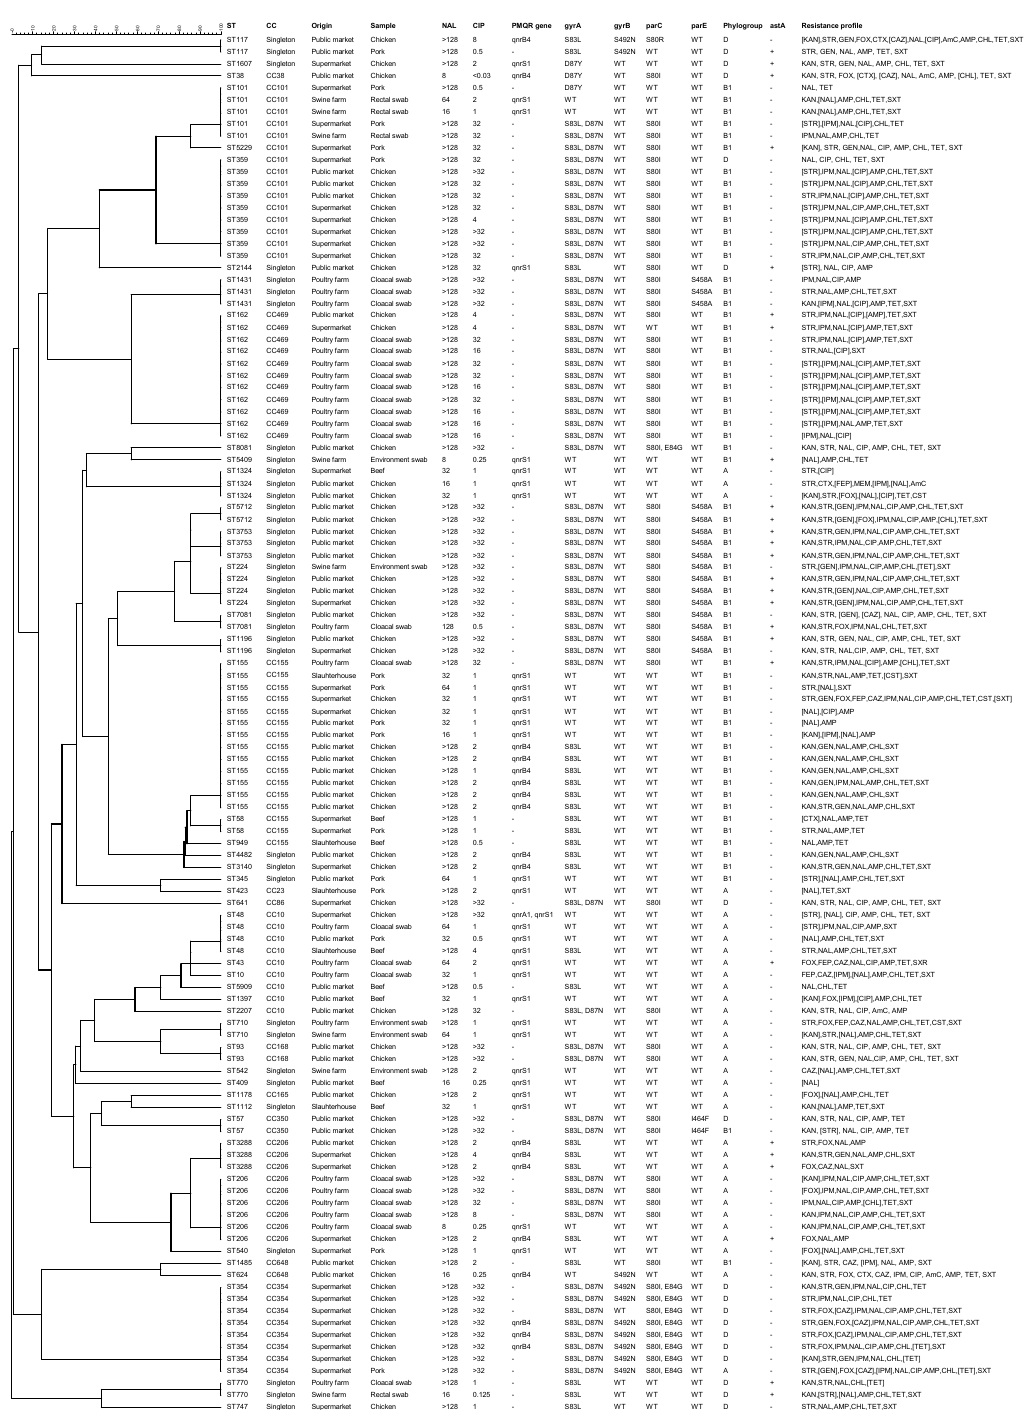
Figure 1. Dendrogram showing the relationship between 115 plasmid-mediated quinolone resistance (PMQR)/quinolone- resistance determining region (QRDR) gene-harboring E. coli strains isolated from beef, chicken, pork, and cloacal, rectal, and environmental swab samples, based on the multilocus sequence typing (MLST) allele profile including information about sequence type (ST), clonal complex (CC), minimum inhibitory concentration (MIC) of nalidixic acid (NAL)/ciprofloxacin (CIP), gyrase/topoisomerase substitutions, phylogroup, virulence gene ( astA ), and phenotypic resistance profile according to the Kirby–Bauer disc diffusion method. KAN—kanamycin; STR—streptomycin; GEN—gentamicin; FOX—